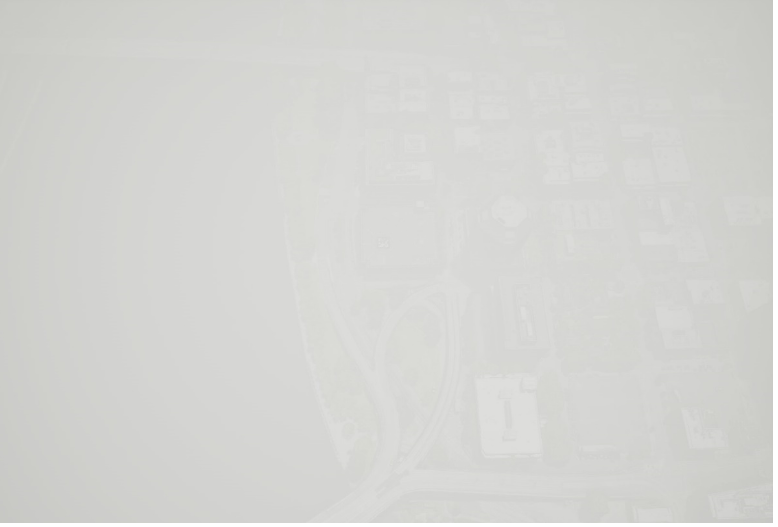
Figure 17. UE4 reproduction of Portland heliport and its surroundings with uniform fog (reproducing maximum meteorological visibility of 500 m).